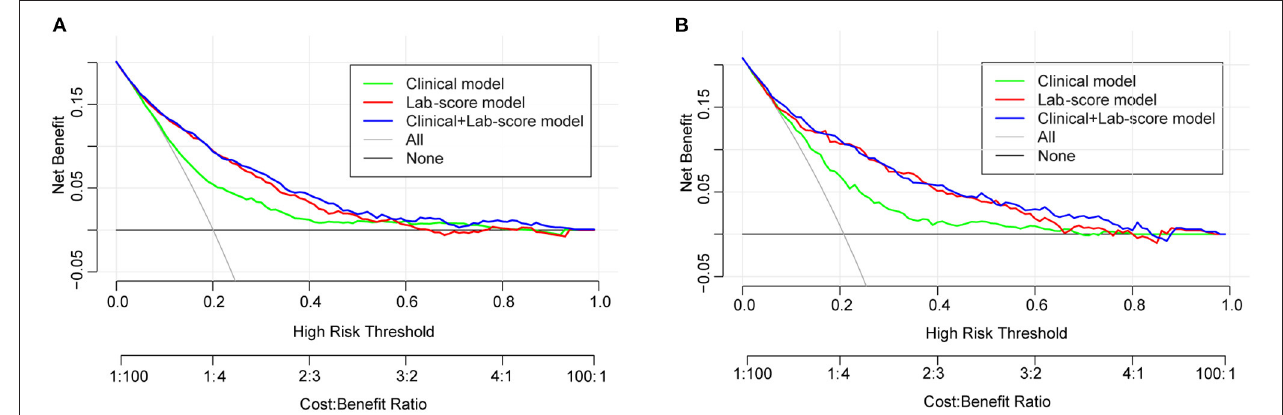
FIGURE 5 | (A) Decision curve analysis for the clinical-lab nomogram. The y-axis measures the net benefit. The red line represents the lab-score nomogram. The blue line represents the clinical-lab nomogram. The green line represents the clinical nomogram. Thin black line represents the assumption that no patients have IAID. (B) The net benefit was calculated by subtracting the proportion of all patients who are false positive from the proportion who are true positive. The net benefit was comparable, with several overlaps, on the basis of the clinical-lab nomogram and the lab-score